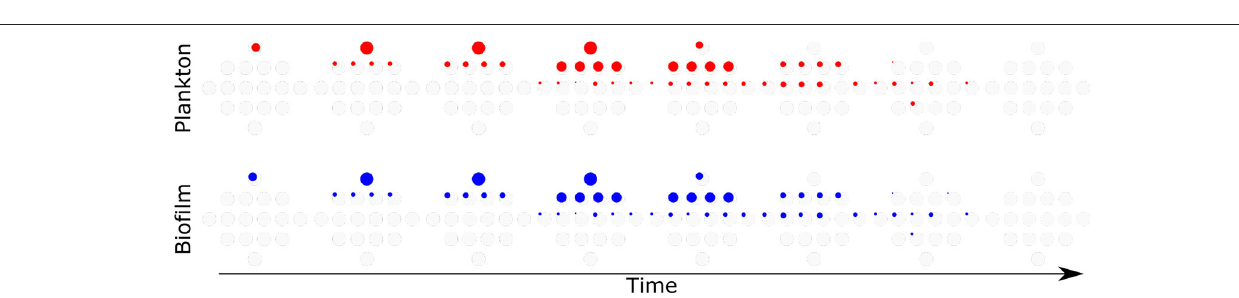
FIGURE 11 | Attachment and dispersal 0.1. Red—plankton, Blue—biofilm. From left to right—time, population composition is analyzed every 24 h. The diameter of the colored circle is proportional to the log 10 size of the population. Light gray circles are placeholders for various genotypes, with a diameter corresponding to the carrying capacity of the